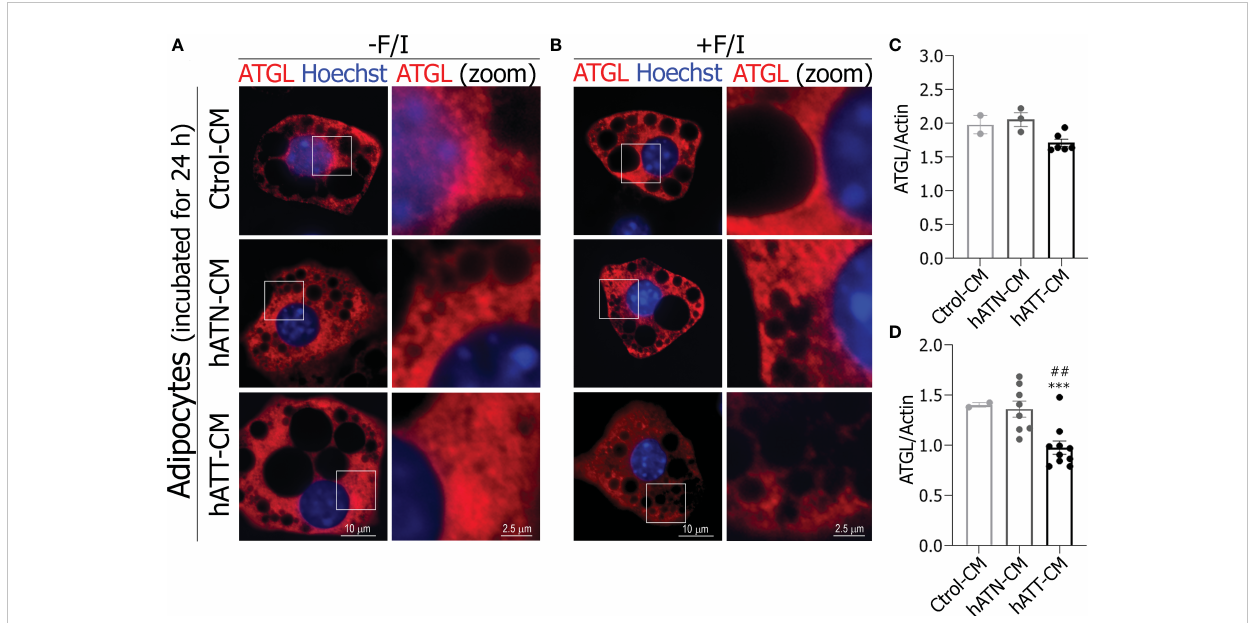
FIGURE 9 Effect of CM from hATN and hATT on localization/expression of ATGL in mature adipocytes. 3T3-L1 adipocytes were incubated with hATN-, hATT- or Ctrol-CM for 24 h followed by incubation with DMSO ( A , -F/I, basal condition) or 20 µM forskolin plus 0.5 mM IBMX ( B , +F/I, lipolytic condition) for 15 min. Then, adipocytes were subjected to IIF with the indicated antibodies, and images were analyzed by confocal microscopy (magni fi cation x600; see Materials and methods section for further details). Boxed areas are shown as zoomed images on right: ATGL (zoom) (n = 3 experiments in duplicate). 3T3-L1 adipocytes were incubated with hATN-, hATT- or Ctrol-CM for 24 (C) and 72 h (D) , and then lysed. ATGL expression level was measured by WB. Actin was used as a loading control. Images were analyzed by densitometry. (n = 2 experiments in duplicate with similar results). Student ’ s t-test with Welch´s correction was performed; ***P<0.001, adipocytes incubated with hATT-CM vs. Ctrol-CM. ##P<0.01, adipocytes incubated with hATT-CM vs. hATN-CM. Ctrol-CM, control conditioned media; hATN-CM, conditioned media from human normal breast